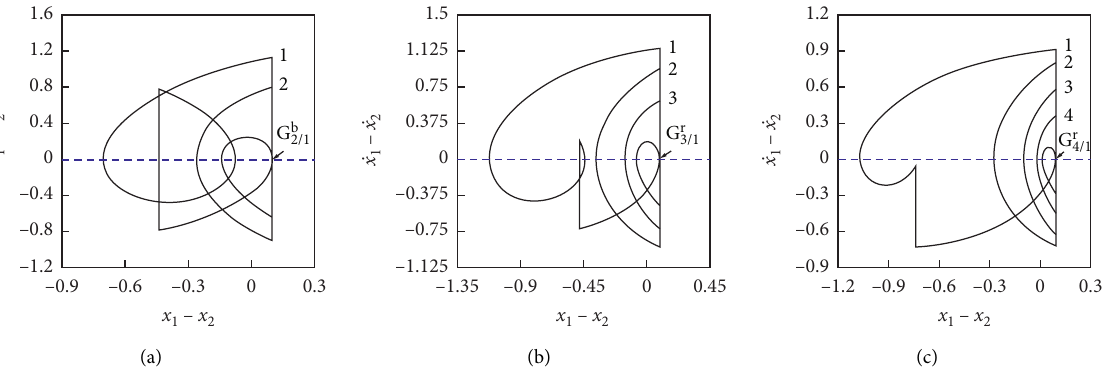
Figure 8: Phase diagrams at grazing bifurcation point. (a) G b